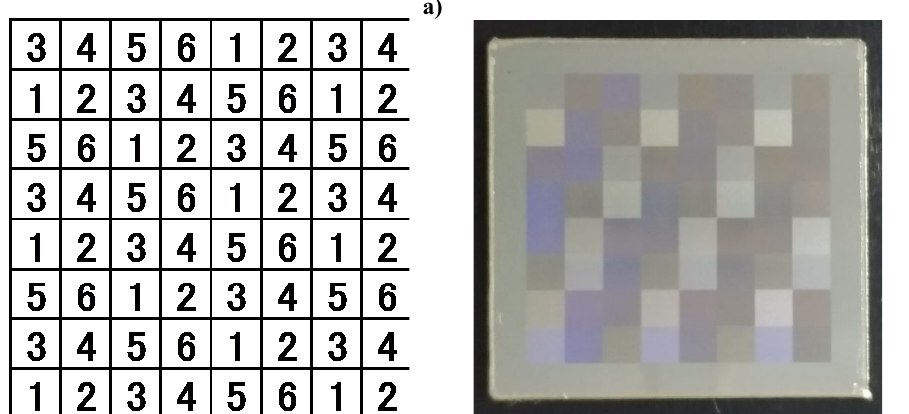
Figure 4. Qualitative control of surface plasmonic state by varying the nano-texture orientation. ( a ) Digital classification of nano-textures for segmentation in laser nano-texturing, and ( b ) nano-textured panel with 8 × 8 segments identified by the different surface-plasmonic reflections.